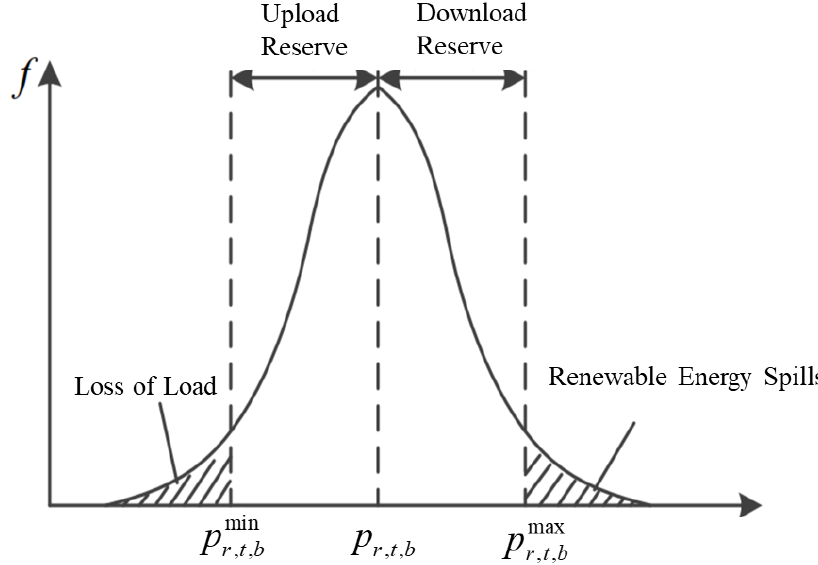
Figure 2. Renewable energy output probability model.